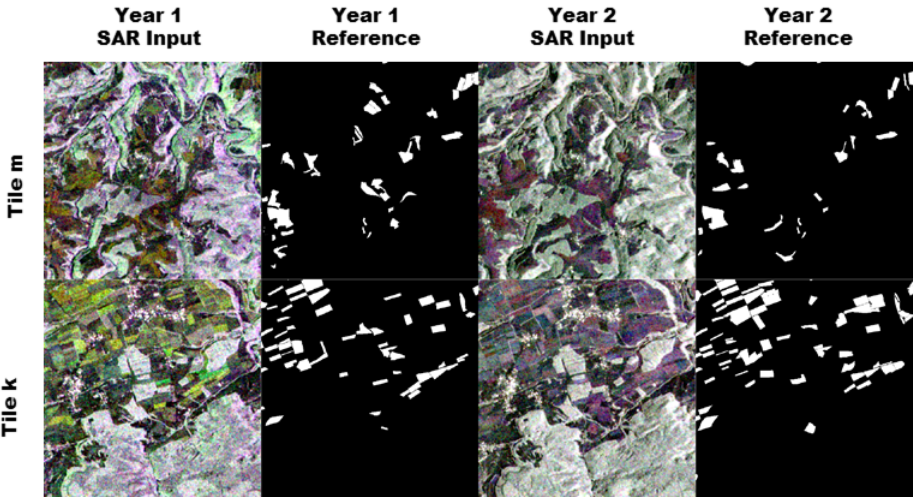
Figure 7. The figure shows a sample for one complete run. The two rows show tile m and k. Columns 1 and 3 show false color composites of the 12 band monthly mean Sentinel-1 images. Columns 2 and 4 show the position of the maize pixels in